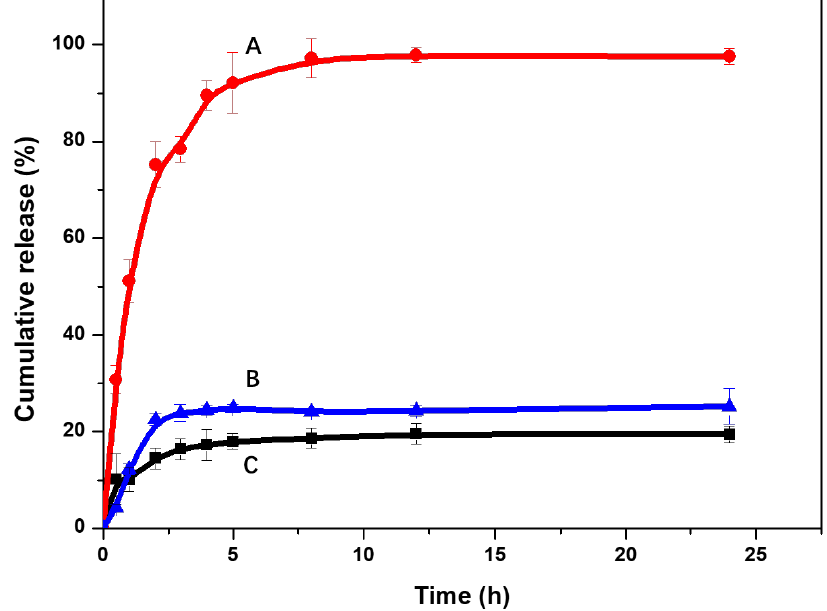
Figure 3. In vitro DOX release profile of DOX-loaded PEG-PU(SS)-PEG micelles at 37 °C (A: PEG-PU(SS)-PEG micelles + 10 mM DTT; B: PEG-PU-PEG micelles + 10 mM DTT; C: PEG-PU(SS)-PEG micelles). Error bars represent standard deviation (SD) for n = 3.